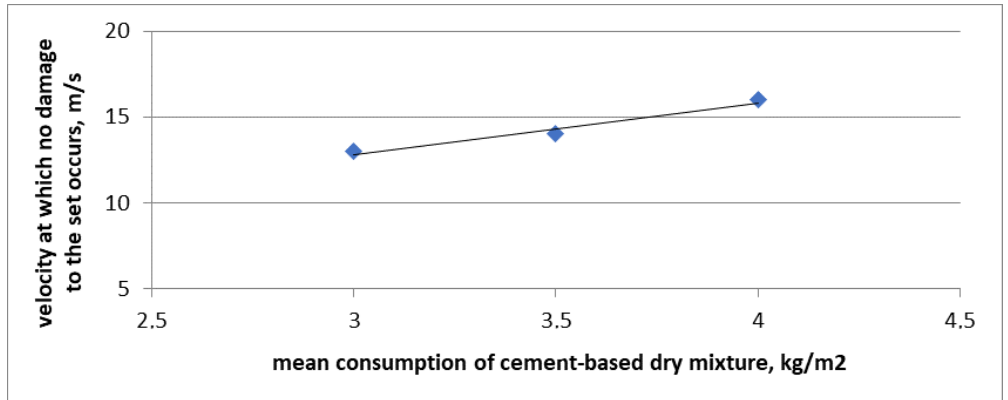
Figure 7. Comparative specifications of resistance to hail puncture and consumption of cement-based dry mixture used for making the reinforcement layer.